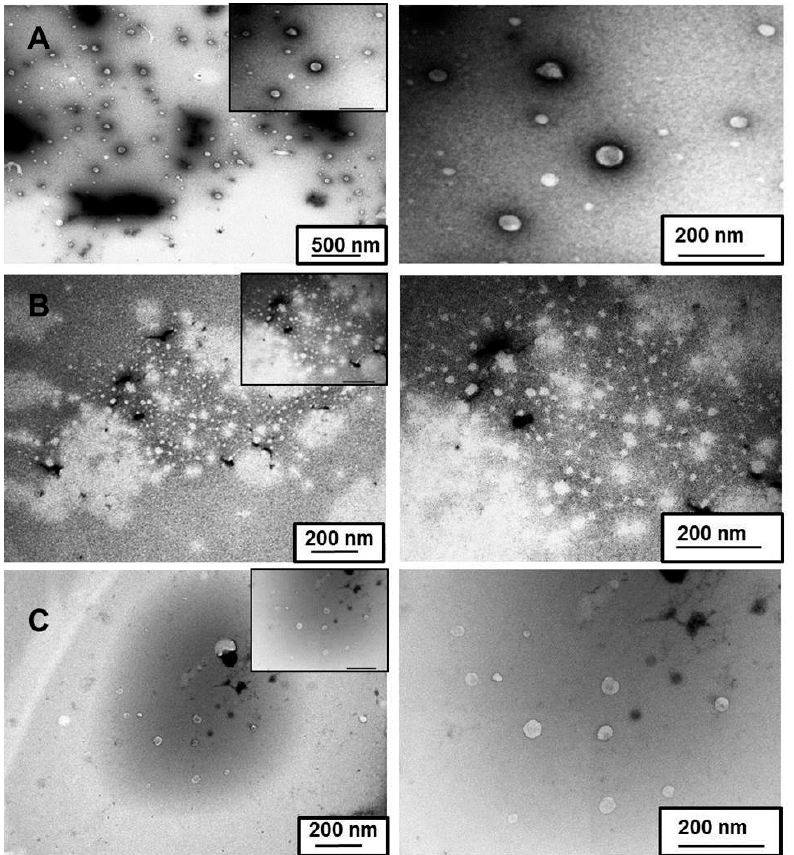
Figure 7. Transmission electron microscope (TEM) images of ( a ) F2 magnified by 15 k (left) and 60 k (right), ( b ) F3 magnified by 30 k (left) and 60 k (right) and ( c ) F5 magnified by 30 k (left) and 60 k (right).